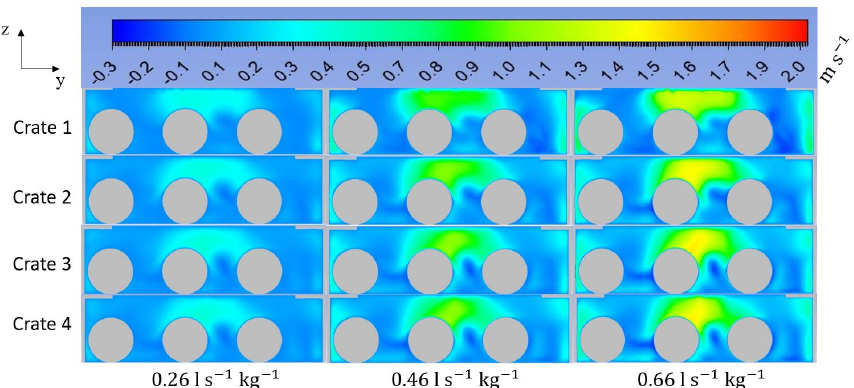
Figure 11. Influence of the airflow rate on the air velocity at the crate inlets (crate B).